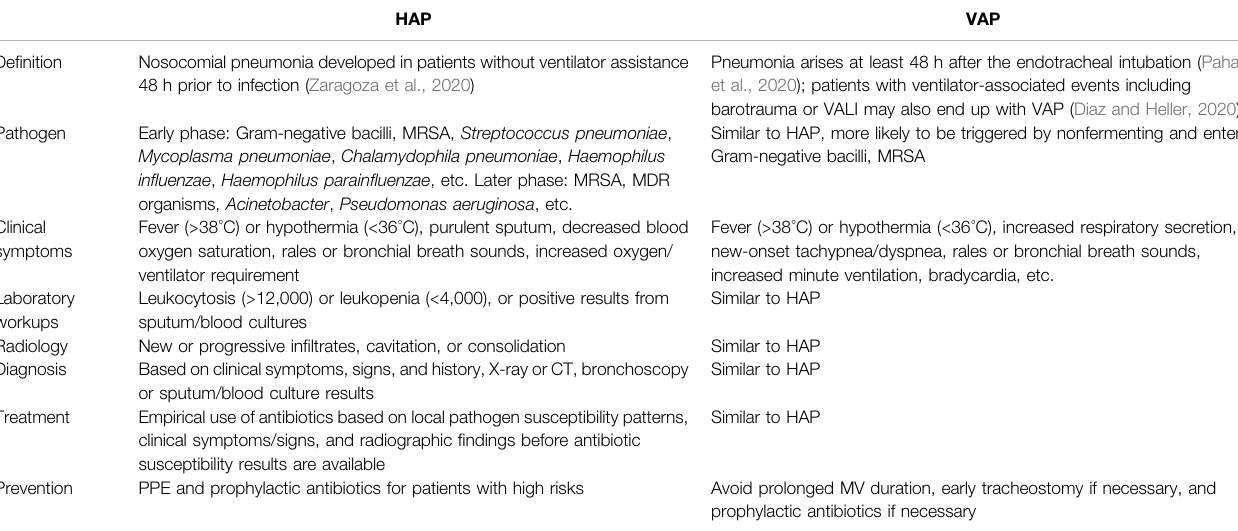
TABLE 4 | Differences and Similarities between HAP and